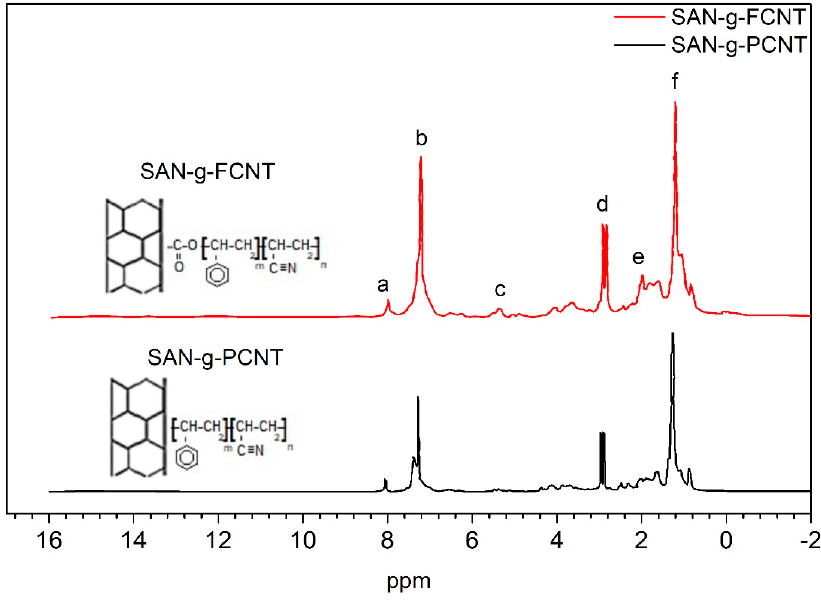
Figure 7. 1 H-NMR spectra for the SAN-grafted CNTs: SAN-g-PCNT and